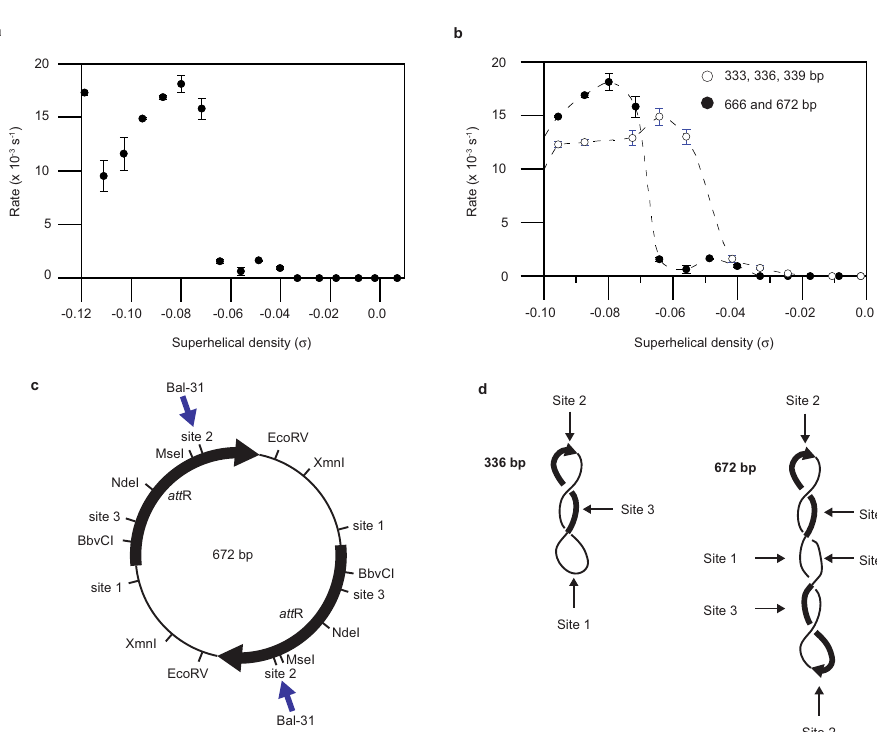
Fig. 5 Curvature and sequence affect supercoiling threshold for DNA base exposure. a Bal-31 cleavage rates of double-sized (666 and 672 bp) minicircle topoisomers as a function of superhelical density. The assay was repeated three times for each topoisomer and mean values are shown. Error bars represent standard deviations; when not visible, they were smaller than the symbol. b Comparison of thresholds of Bal-31 activity for different sized minicircles. Data from Figs. 4a and 5a were overlaid on the same plot to facilitate comparison. Fitted lines are for visualization purposes only. c Map of the double-length minicircle sequence. Arrows indicate the position of Bal-31 cleavage of the 672 bp Lk = 58 ( Δ Lk = − 6; σ = − 0.096) topoisomer (see Source Data for these results). Double-length minicircles employed in this study have two copies of the monomeric minicircle sequence in direct orientation. d Model for why Bal-31 preferentially cleaves site 1 in the 336 bp minicircle but site 2 in the 672 bp minicircle. Site 2 is localized to one of the superhelical apices, placing site 1 at the opposite apex. In the 336 bp minicircle; however, in the 672 bp minicircle, another copy of site 2 is found at the opposite